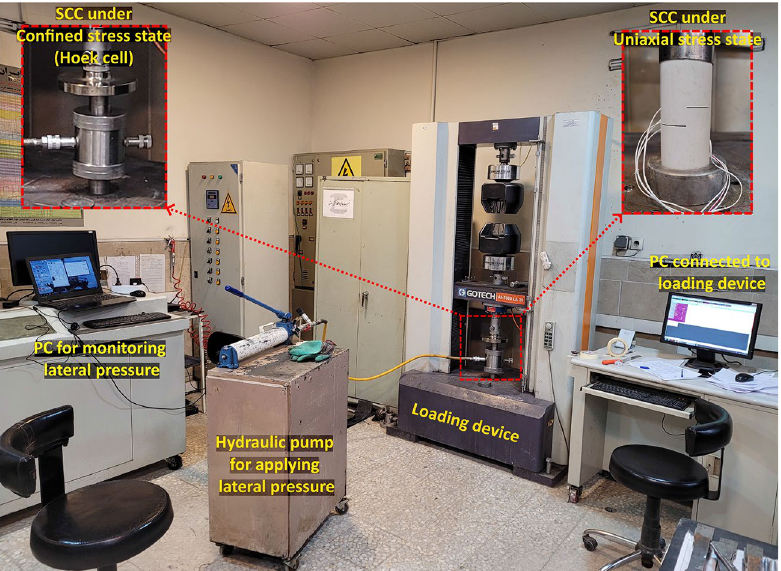
Figure 6. Loading device and lateral pressure unit used in this study to test SCC samples under uniaxial and confined stress states.